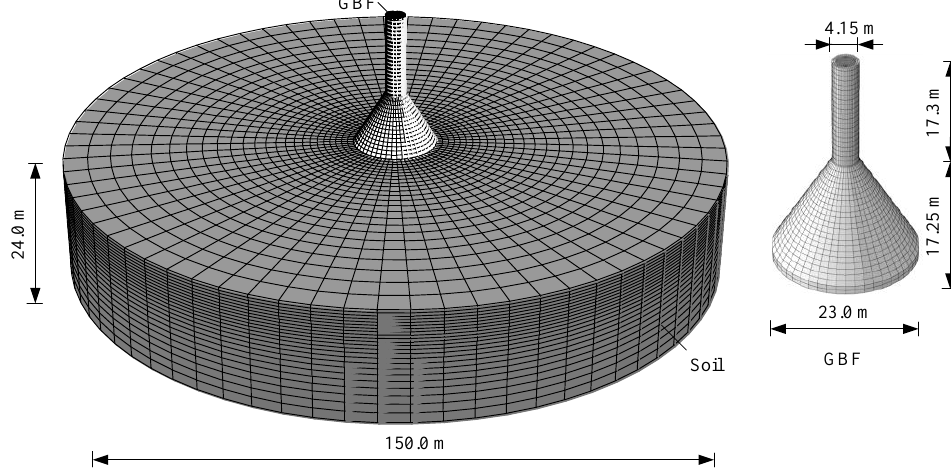
Figure 7. Finite mesh for lateral dynamic analysis of the GBF.